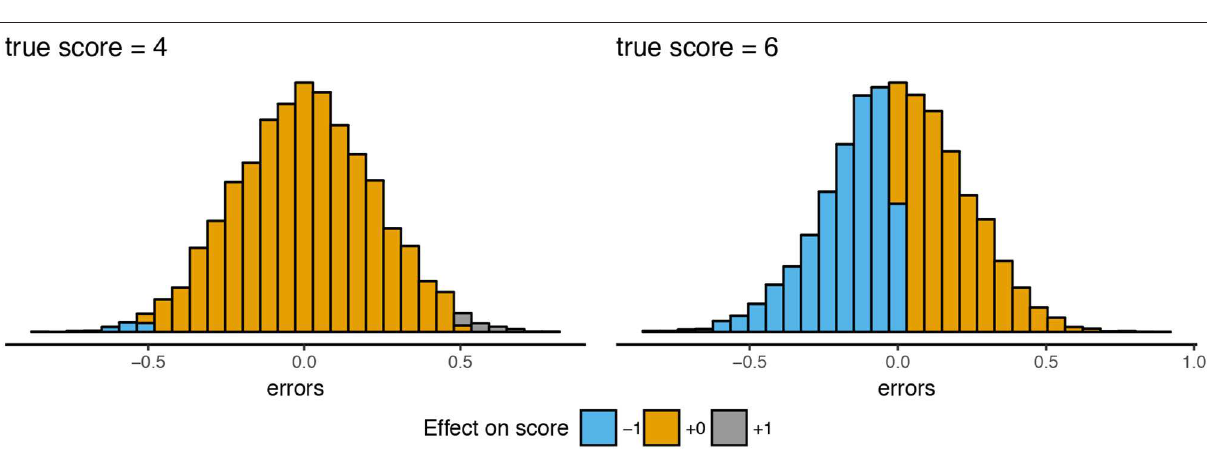
“true” score and error variance becomes more or less